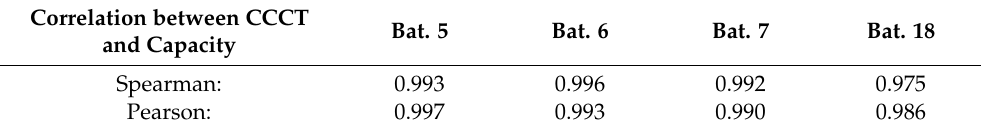
Table 1. The Spearman and Pearson correlation analysis.